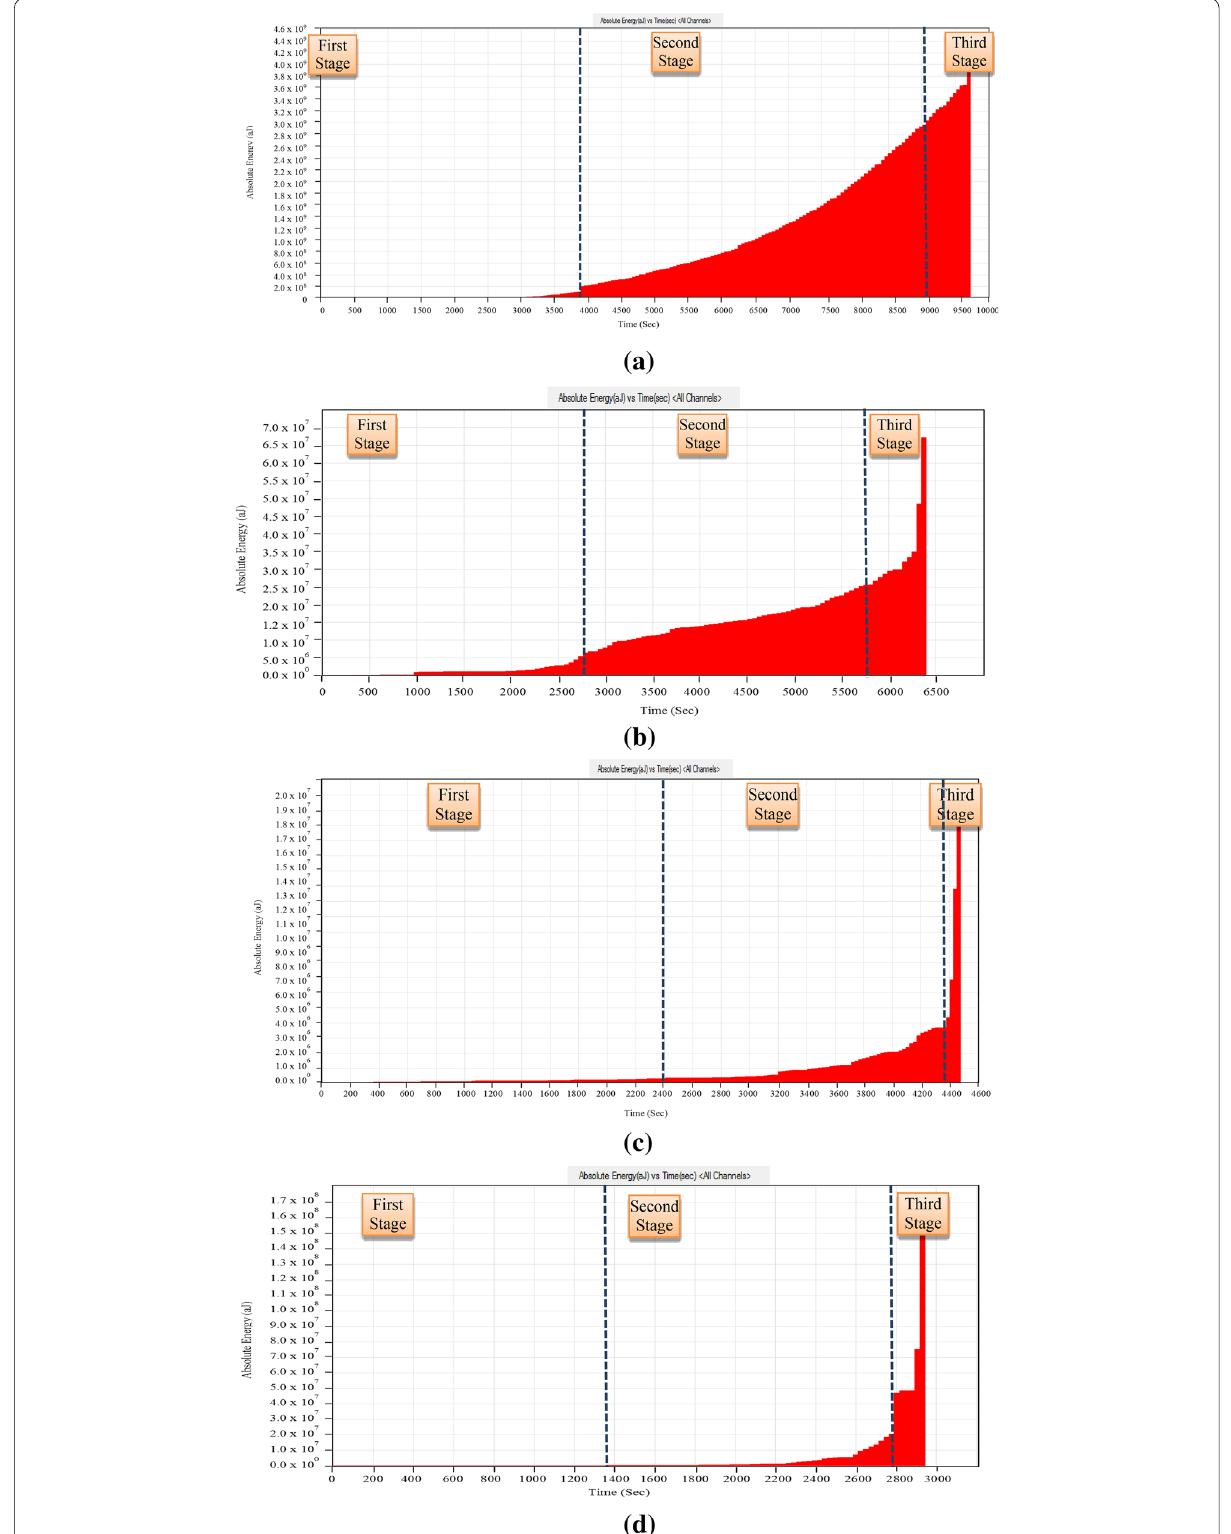
Fig. 5 The AE absolute energy of ( a ) Type I beam, ( b ) Type II beam ( c ) Type III beam, ( d ) Type IV